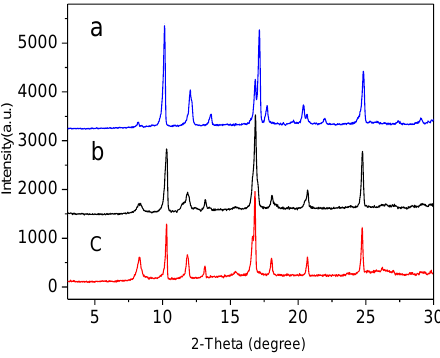
Figure 2. XRD patterns of ( a ) Cu(BDC)(DMF), ( b ) Cu(BDC-NH 2 )(DMF) and ( c ) Et- N -Cu(BDC-NH 2 )(DMF).